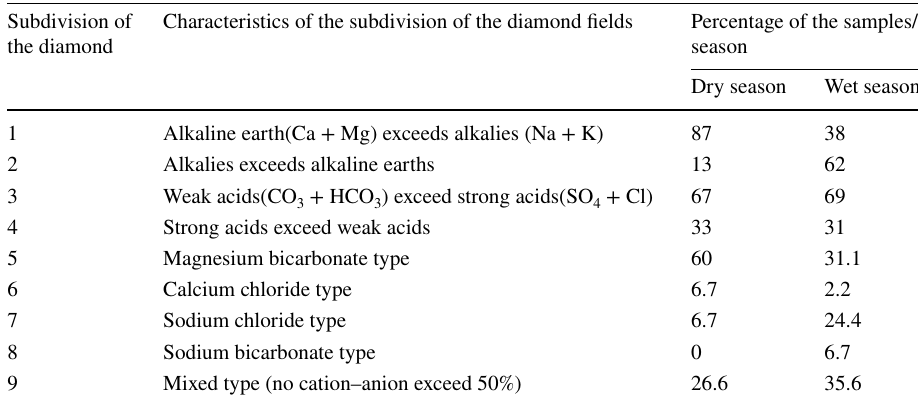
Subdivision of Characteristics of the subdivision of the diamond fields Percentage of the samples/ the diamond